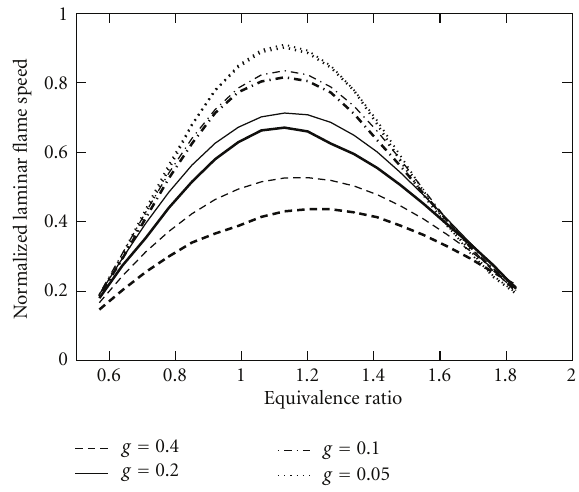
Figure 17: Dependencies of the probability of finding flammable mixture composition on the mean equivalence ratio F , calculated invoking the beta-function (thin curves) and the R-2 δ (bold curves) PDFs. g = 0 . 2. (1) F min = 0 . 4 and F max = 2 . 2, (2) F min = 0 . 3 and F max = 2,5, (3) F min = 0 . 1 and F max = 4 .